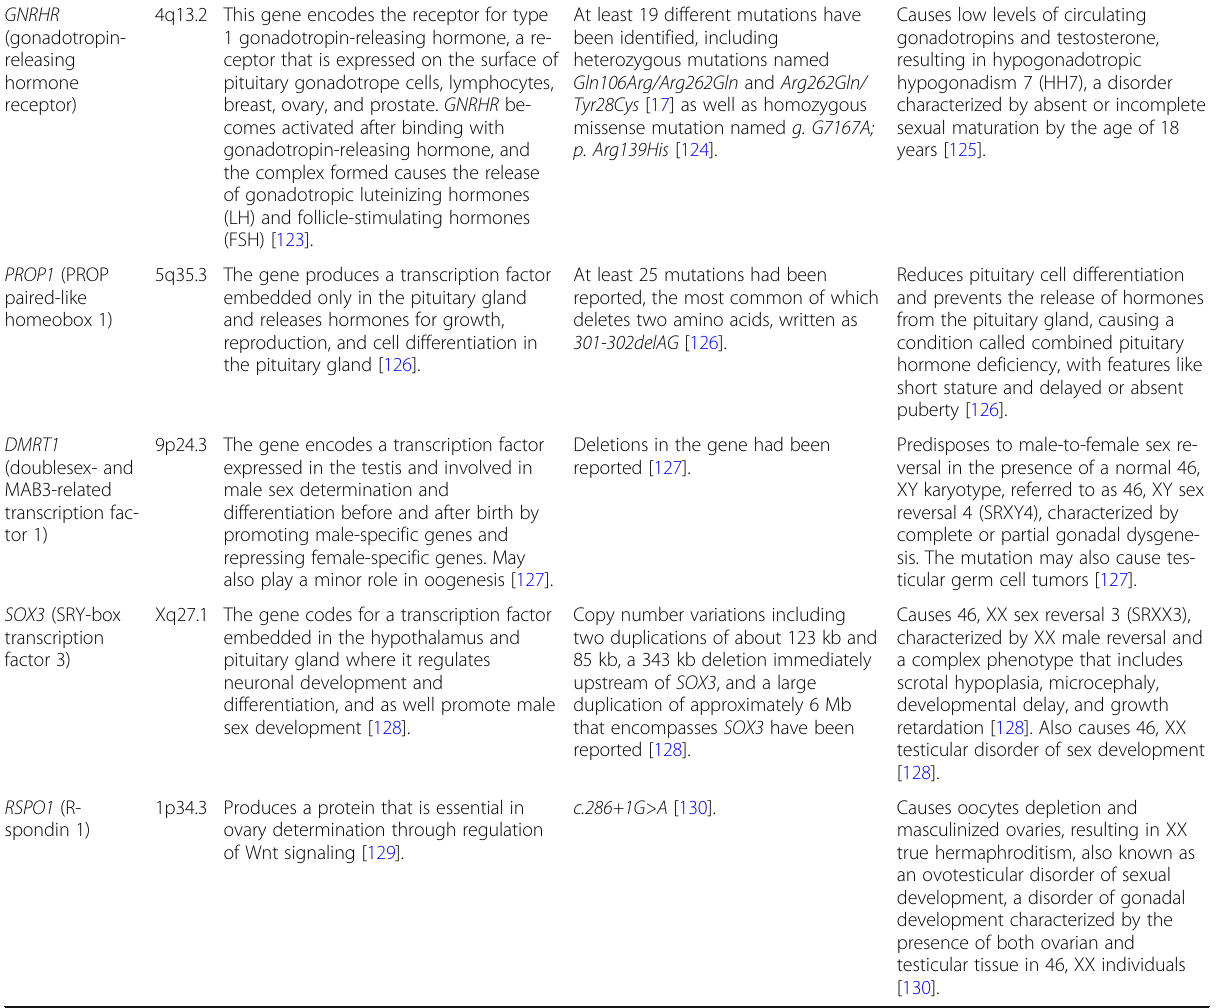
Table 3 Genes predisposing to nonsyndromic sex reversal and pubertal